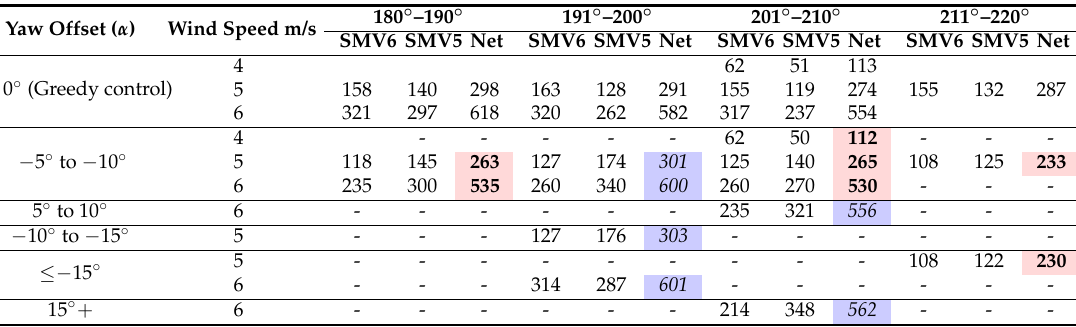
Table 6. Comparison of power productions(kW) of SMV6 and SMV5 obtained with SCADA data during the experiment with greedy control. Light blue shaded and italicized cells: Increase in net production. Light red shaded and bold: Decrease in net